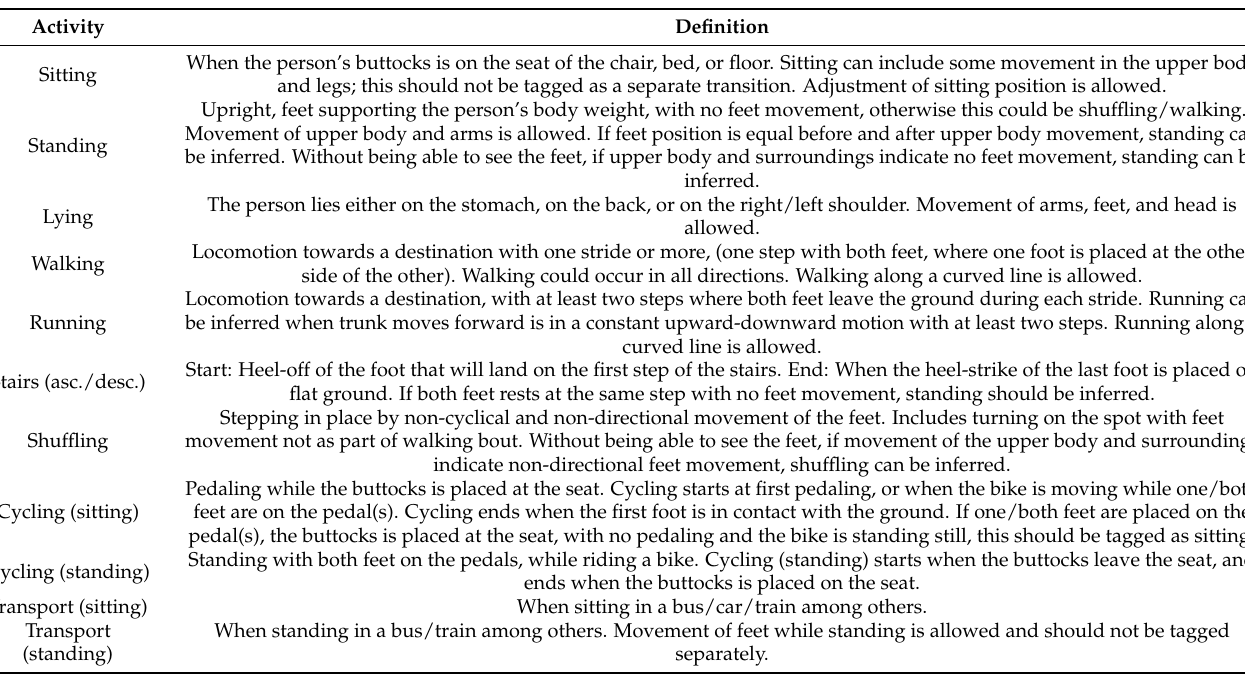
Table A1. The definitions of all twelve activities used during